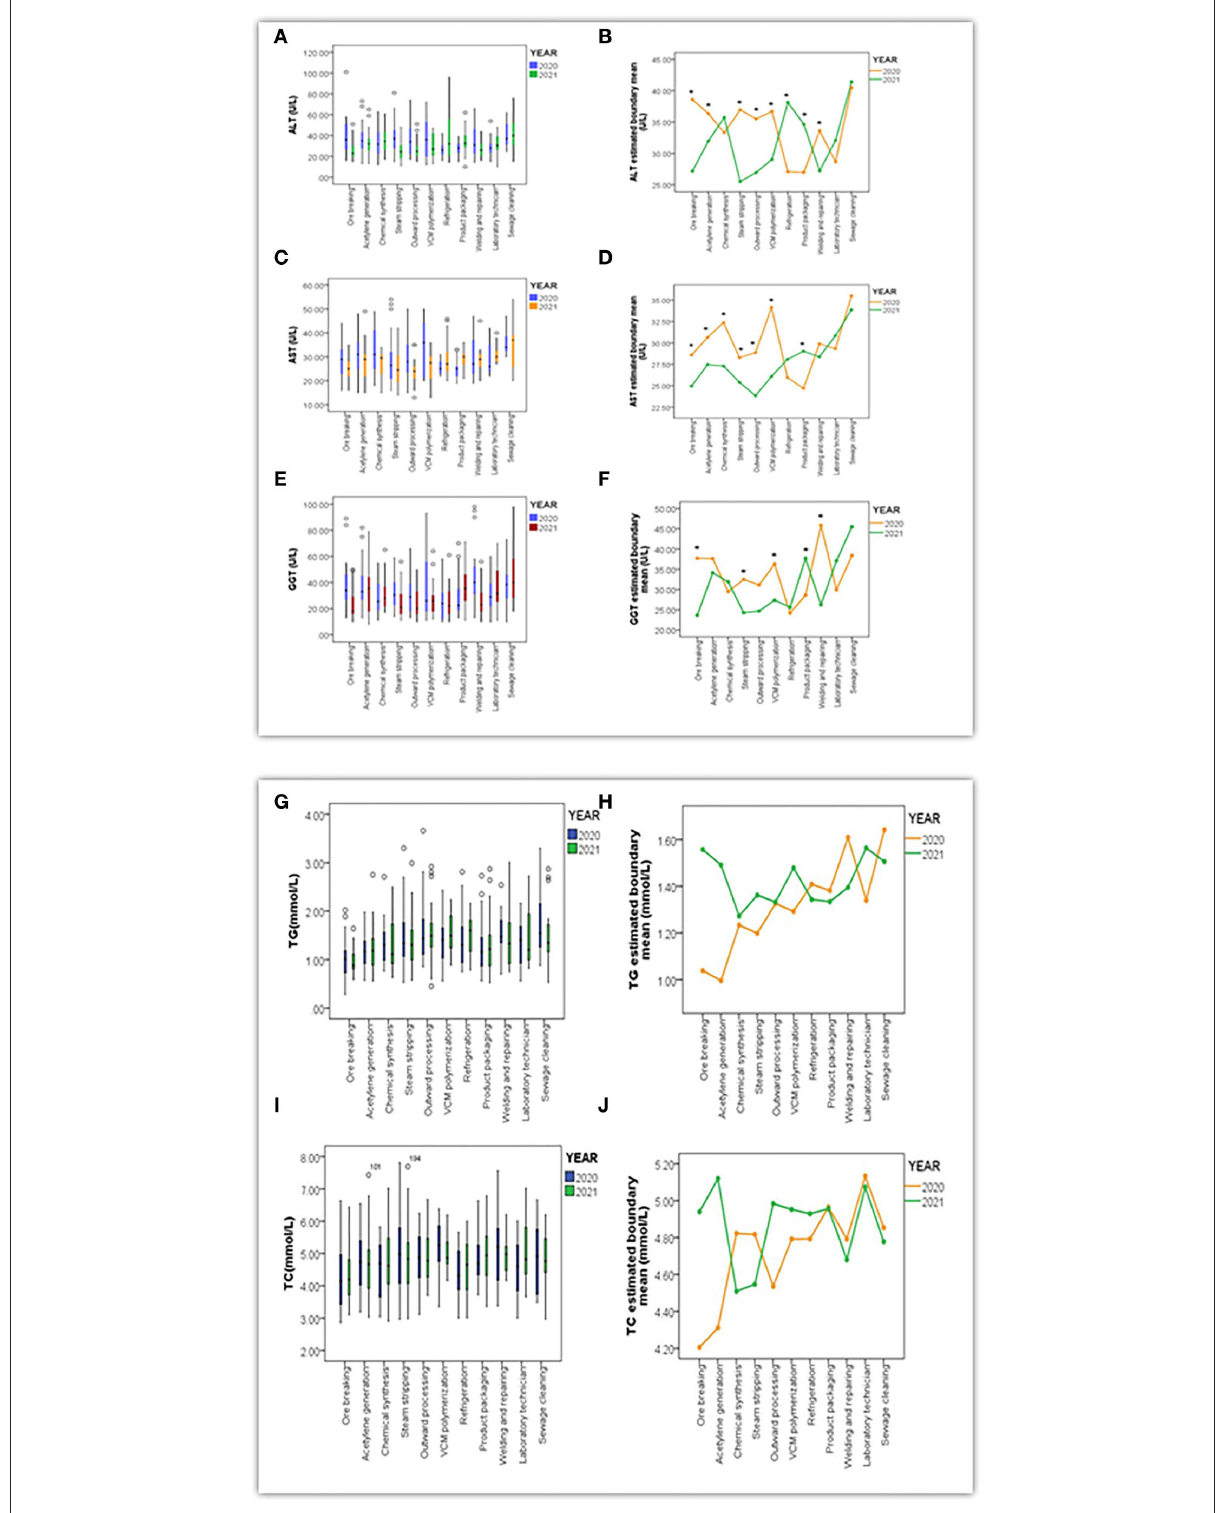
FIGURE4 Box charts (A,C,E,G,I) presented the quantitative distribution extent of variables in ALT (U/L), AST (U/L), GGT (U/L), TG (mmol/L) and TC (mmol/L) throughout positions in Y between 2020 and 2021; Line Charts (B,D,F,H,J) indicated differentiation of estimated boundary mean for ALT, AST, GGT, TG, and TC under the bilateral interaction effect between year and position (*referred to P < 0.05 when differences of variables were